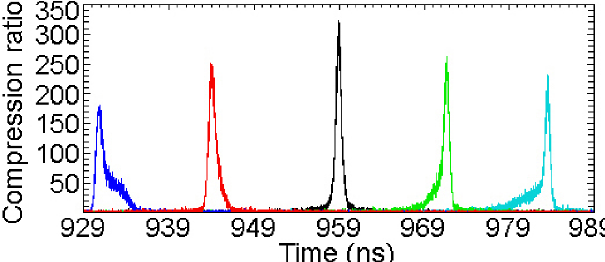
(cid:2) t (cid:3) =I FIG. 20. (Color) Compression ratio I comparison in the b 0 variations using the laboratory frame for (cid:13) 5% constant E 0 smooth waveform across the finite-size gap and T k (cid:4) 0 : 2 eV (cid:4) 420 keV (light blue) at z (cid:4) (cid:8) 65 : 0 cm , E (cid:4) beams for E 0 0 (cid:4) 400 keV (black) at 410 keV (green) at z (cid:4) (cid:8) 62 : 3 cm , E 0 (cid:4) 390 keV (red) at z (cid:4) (cid:8) 56 : 4 cm , and z (cid:4) (cid:8) 59 : 5 cm , E 0 (cid:4) 380 keV (dark blue) at z (cid:4) (cid:8) 53 : 6 cm . The plots are color E 0 coded to the profiles of the same color in Fig. 19.